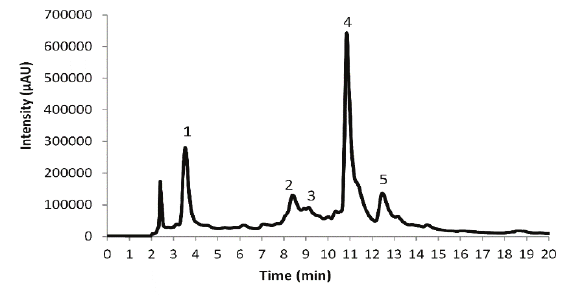
Figure 1: HPLC-DAD chromatogram of Salvia sclareoides infusion: ( 1 ) unknown, ( 2 ) luteolin diglucuronide, ( 3 ) sagerinic acid, ( 4 )